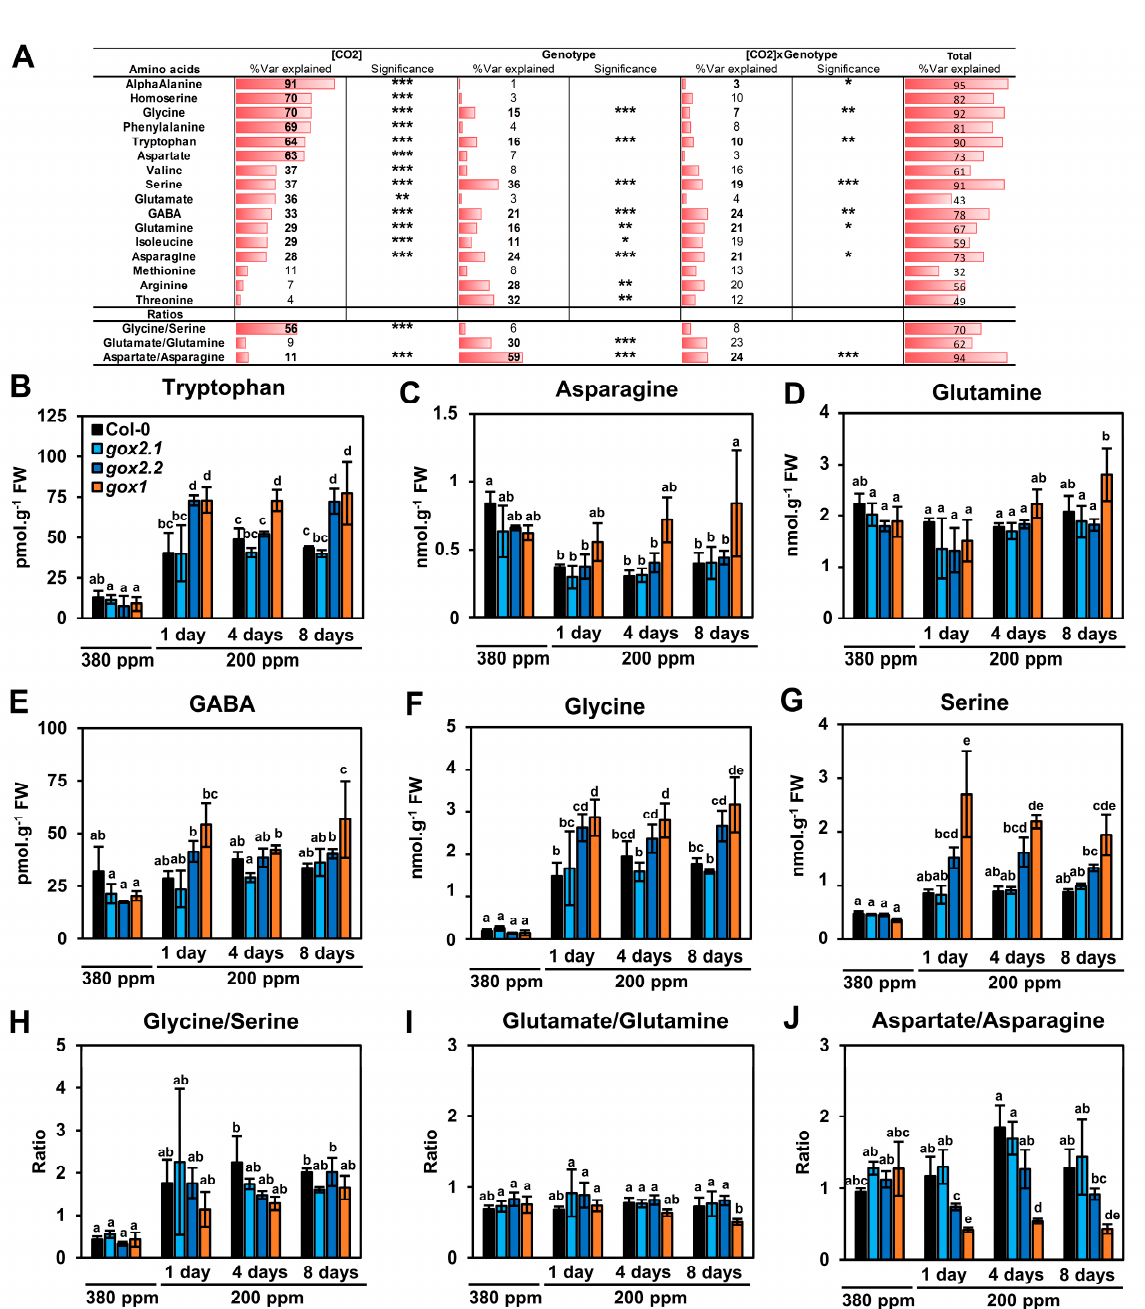
Figure 4. Statistical analyses of amino acid variations associated with long-term low CO 2 treatment (200 ppm) in gox1 and gox2 mutants. ( A ) Two-way ANOVA analysis of amino acid contents from rosette leaves of Col-0, gox1 and gox2 mutants after 1, 4 or 8 days of exposure to an atmosphere with 200 ppm of CO 2 . ( B ) Tryptophan, ( C ) asparagine, ( D ) glutamine, ( E ) GABA, ( F ) glycine and ( G ) serine contents. Ratios for ( H ) glycine/serine, ( I ) glutamate/glutamine, ( J ) aspartate/asparagine. Results are expressed as the mean ± standard deviation of three independent biological replicates. Different letters indicate groups of mean values that are significantly different between the different conditions (two-way ANOVA test followed by a post-hoc Tukey HSD test, p -value < 0.05). *** p -value < 0.001; ** p -value < 0.01; * p -value < 0.05. Var = Variance.